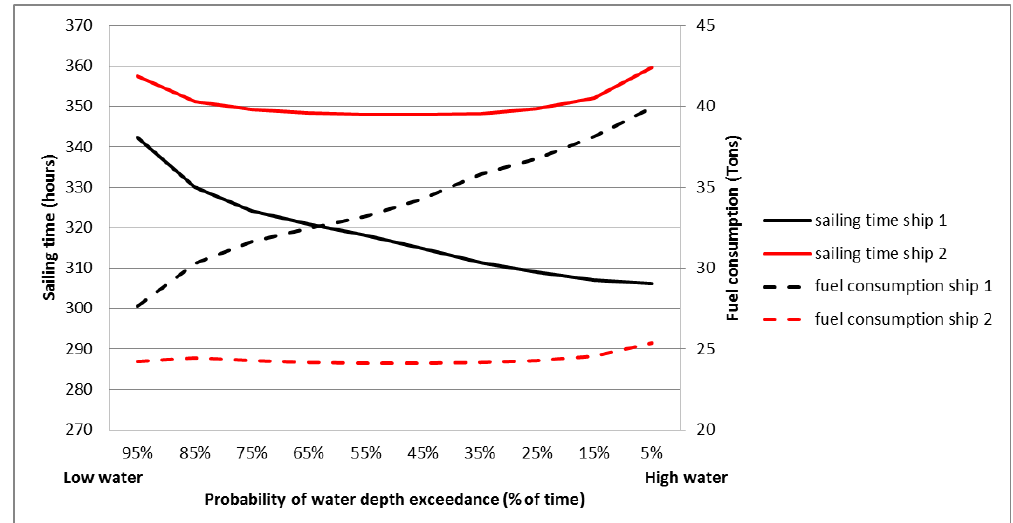
Figure 7. Roundtrip sailing time and fuel consumption - 'sensible sailing' From Figure 7, the large impact of different water levels and installed power becomes apparent.